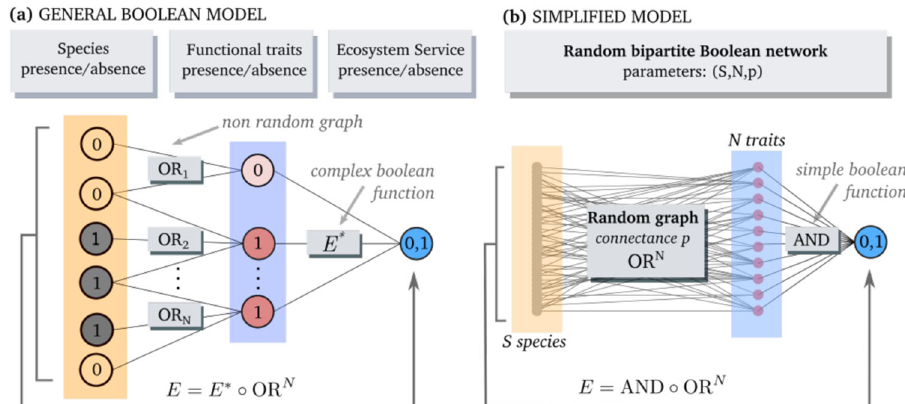
Fig. 2 A Boolean model for ecosystem services. a We view an ecosystem service as a Boolean function E over the presence/absence con fi gurations of S species (leftmost column). We distinguish species from their N functional traits (middle column). The con fi guration of any trait n is de fi ned by the logical OR function over the S n species that share that trait. This amounts to writing E as the composition E ¼ E (cid:3) (cid:4) OR N , which should aim to remove as much functional redundancy as possible from the auxiliary function E (cid:3) over trait con fi gurations. b We simplify our model further by (i) considering random species-to-trait associations with connectance p and (ii) choosing the logical AND function for E (cid:3) [that is, the least redundant function, which we show (Supplementary Methods) is representative of a random choice across the space of all Boolean functions]. In this model (see ‘ Methods ’ for full description), we can deduce analytical expressions for the percentiles of the distribution (considering all possible extinction sequences) of robustness of ecosystem service supply R : the fraction of species loss leading to loss of service